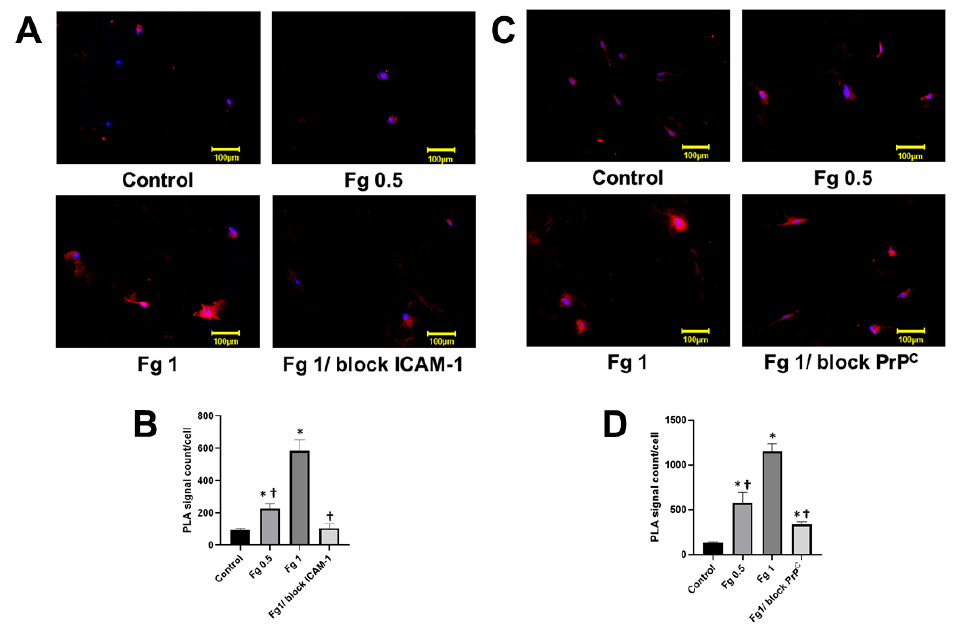
Figure 1. Interaction of fibrinogen (Fg) with its astrocytic receptors, intercellular adhesion molecule 1 (ICAM-1) and cellular prion protein (PrP C ) detected by proximity ligation assay (PLA). ( A ) Representative images of in situ PLA signal (shown in red) depicting an interaction between Fg and astrocyte ICAM-1. Cells were treated with medium alone (control), 0.5 mg/mL of Fg (Fg 0.5), 1 mg/mL of Fg (Fg 1), and 1 mg/mL of Fg in the presence of function-blocking antibody against ICAM-1 (Fg1/block ICAM-1) for 17 h. The blocker of ICAM-1 function was added to cells 2 h prior to Fg treatment. Fg and ICAM-1 were detected using anti-Fg and anti-ICAM-1 antibodies, respectively. Cellular nuclei were labeled with 4 ′ ,6-diamidino-2-phenylindole (DAPI, blue). ( B ) PLA signals for Fg and ICAM-1 interactions were quantified and normalized per number of cells in each an image. ( C ) Representative images of in situ PLA signal (shown in red) depicting an interaction between Fg and astrocyte PrP C . Cells were treated with medium alone (control), 0.5 mg/mL of Fg (Fg 0.5), 1 mg/mL of Fg (Fg 1), and 1 mg/mL of Fg in the presence of PrP C function-blocking peptide (Fg1/block PrP C ) for 17 h. The blocker of PrP C function was added to cells 2 h prior to Fg treatment. Fg and PrP C were detected using anti-Fg and anti-PrP C antibodies, respectively. Cellular nuclei were labeled with DAPI (blue). ( D ) PLA signals for Fg and PrP C interactions were quantified and normalized per number of cells in each image. p < 0.05 in all; * - vs. Control, † - vs. Fg1; n = 4.